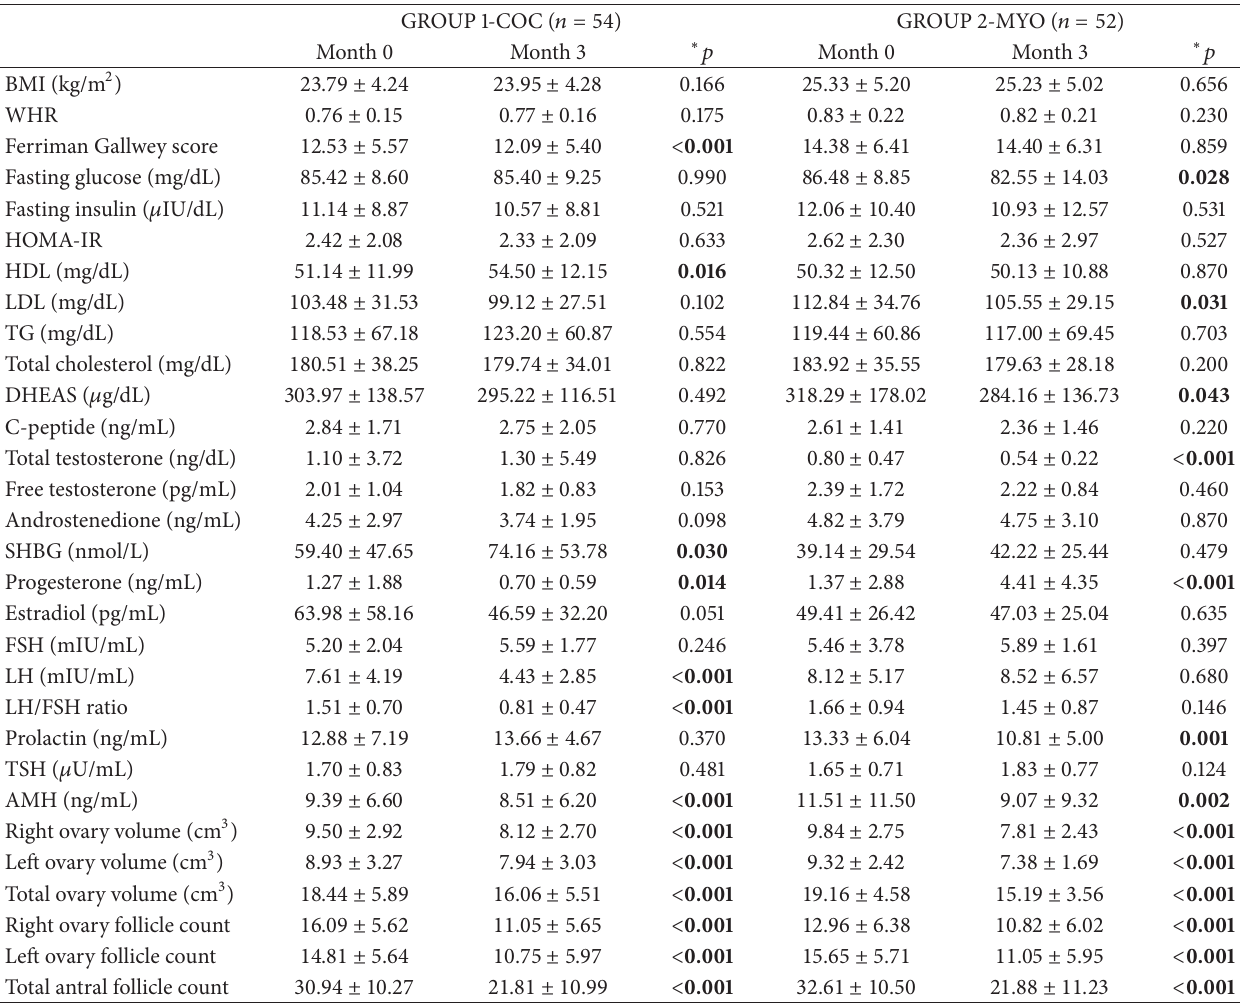
Table 3: Comparison of changes in all parameters after treatment between the groups.